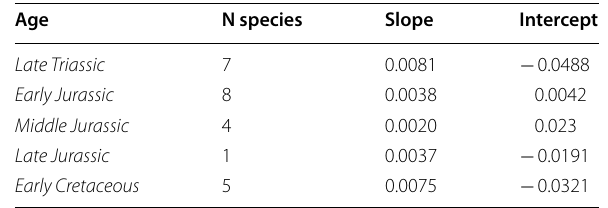
trend within the Mesozoic data (tau 0.112, two-sided = − p -value 0.46; Fig. 12). Since an increase during the end = of the Triassic and in the Early Jurassic as well as a Creta- ceous decrease was expected, the resulting p -values con- firm the expectations. This corroborates the hypothesis that there is no monotonic trend.